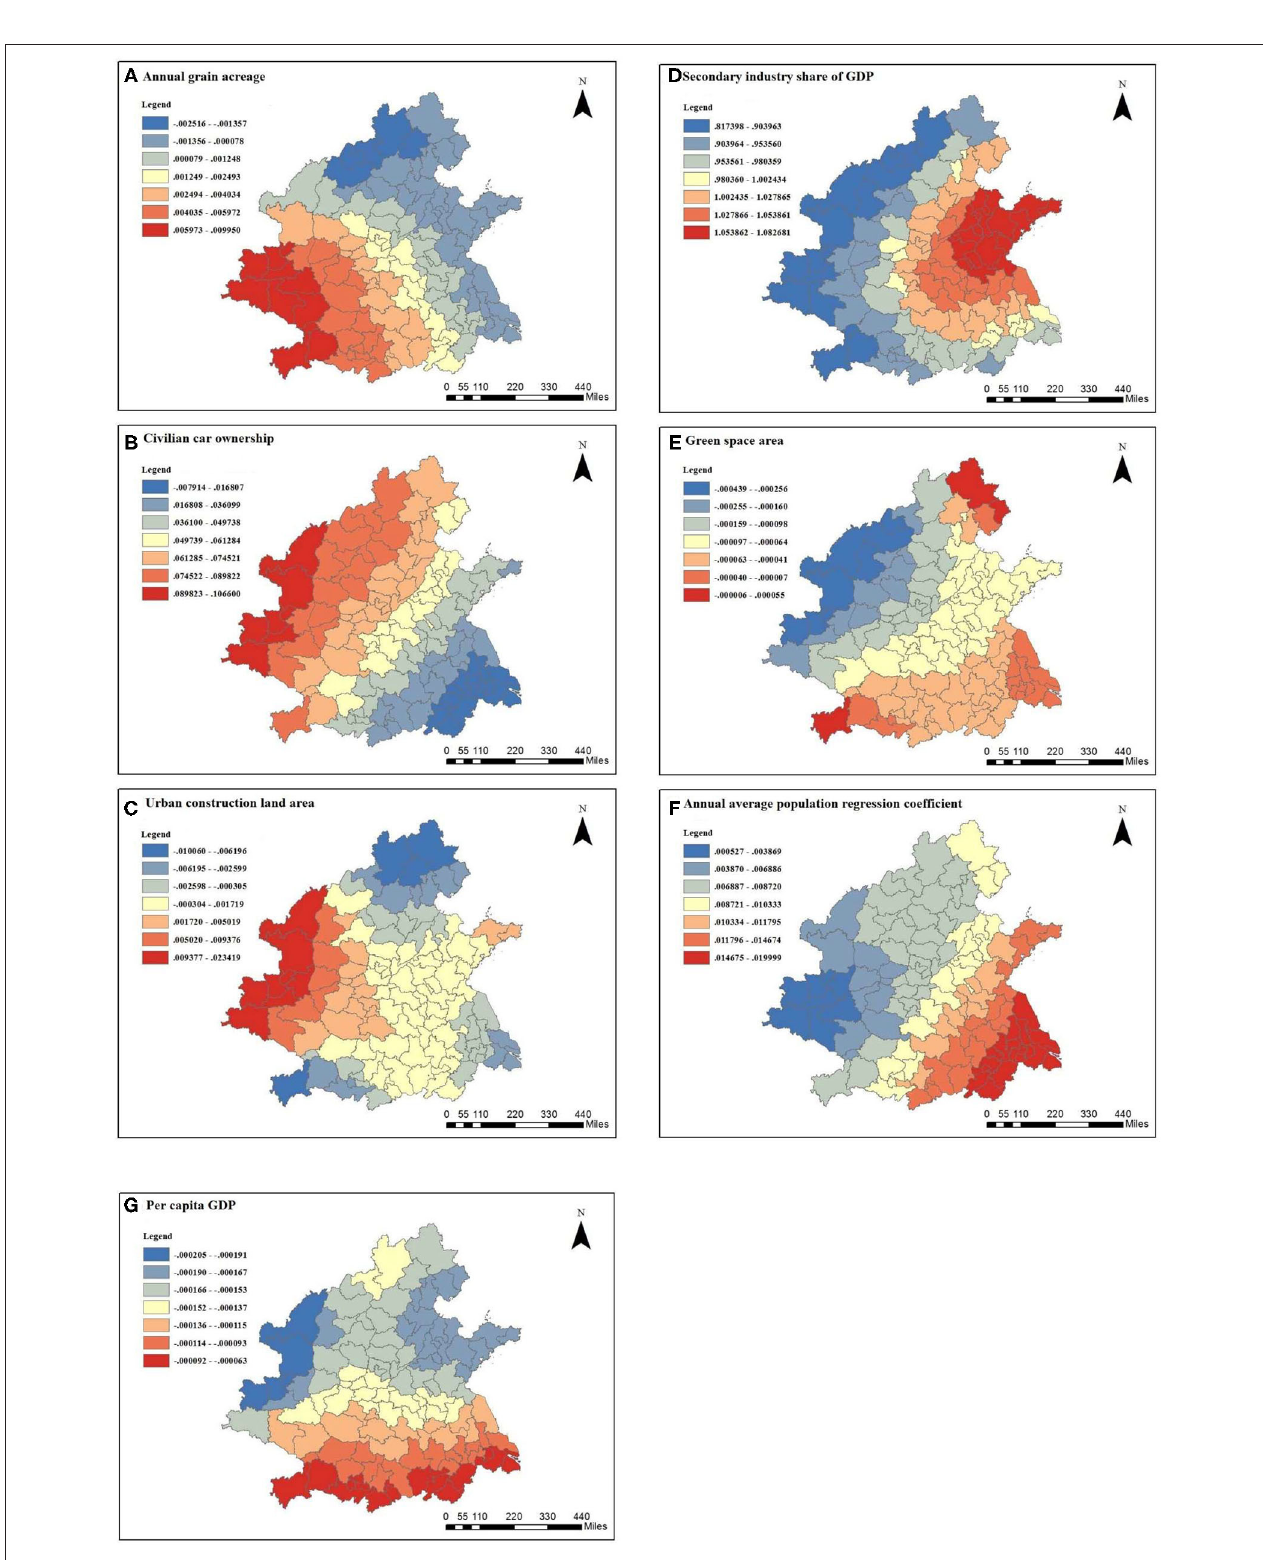
FIGURE 5 | Spatial distribution of the regression coefficients of the parameters in the GWR model: (A) annual grain acreage, (B) civilian car ownership, (C) urban construction land area, (D) secondary industry share of GDP, (E) green space area, (F) annual average population regression coefficient, and (G) per capita GDP.